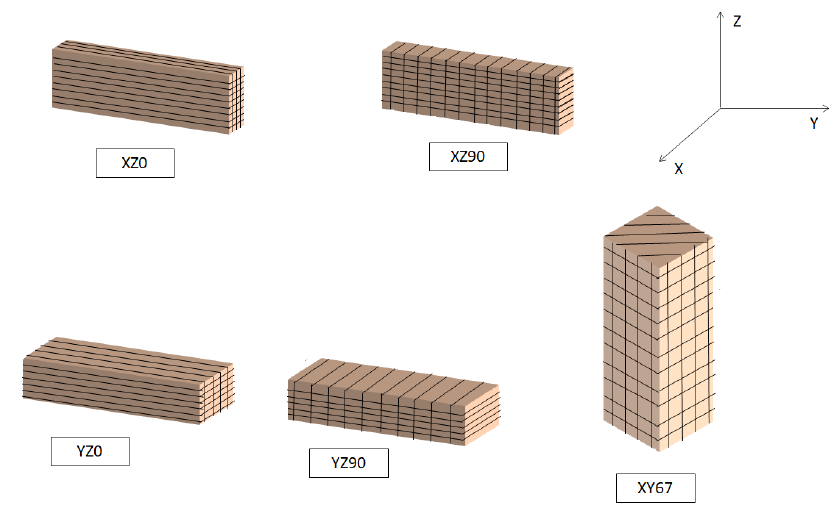
Figure 2. Sample orientations used.